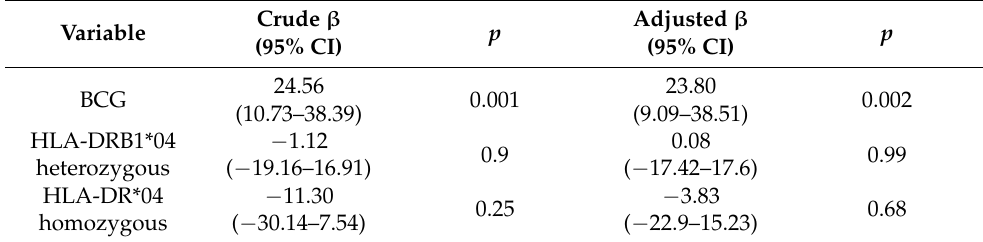
Table 4. Univariate and multivariate regression